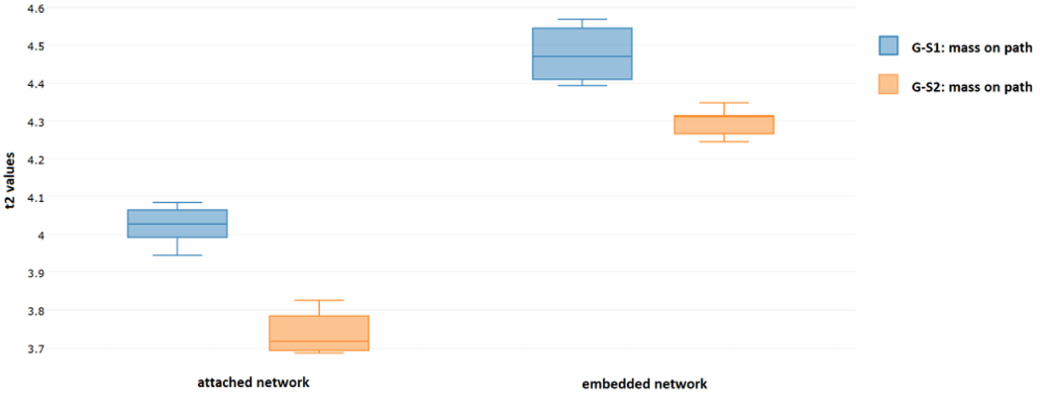
Figure 17. Values of T2 statistics obtained for both PZT